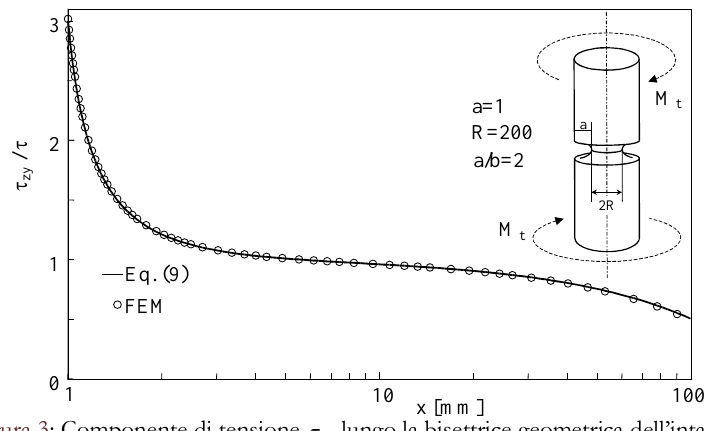
Figura 3: Componente di tensione τ lungo la bisettrice geometrica dell’intaglio. zy Le tensioni sono normalizzate rispetto alla tensione nominale.